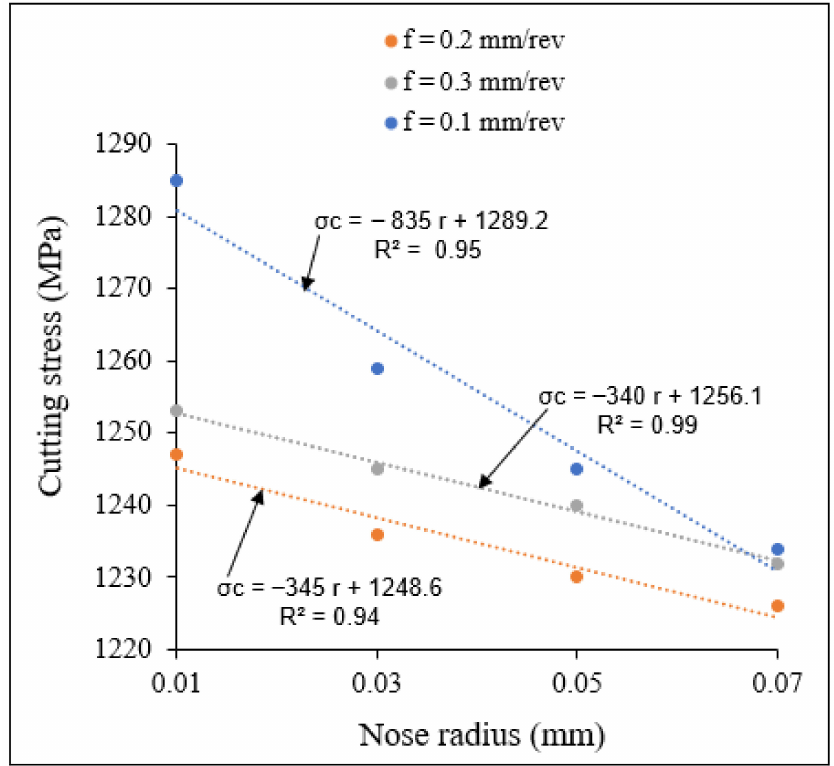
Figure 14. Variation of cutting stress with small tool nose radius at different feed rates at V = 104 m/min, γ = 5.